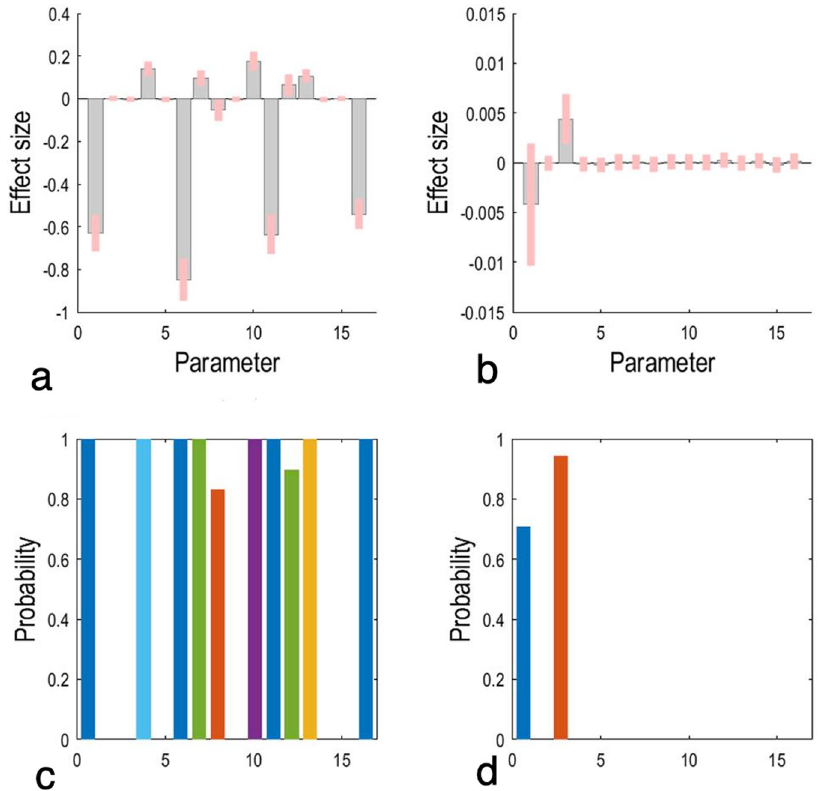
Fig. 3 Correlation results between effective connections and IAT scores through parametric empirical Bayesian framework. a shows each parameter ’ s effect size after Bayesian model averaging for the mean of all subjects, and c shows the corresponding posterior probabilities. b shows the effect size of correlations between each parameter and IAT scores and d shows the corresponding posterior probabilities. Here the threshold of the posterior probability is set to 0.9, so the current results indicate that a positive correlation between connection strength and IAT is observed in effective connection from the MFG to left putamen (i.e., parameter 3 in b , d ). IGD: 174 subjects; RGU: 244 subjects. Note: parameter 1: self-connection from left MFG to left MFG; parameter 2: effective connection from left MFG to left NAcc; parameter 3: effective connection from left MFG to left putamen; parameter 4: effective connection from left MFG to right MFG; parameter 5: effective connection from left NAcc to left MFG; parameter 6: self-connection from left NAcc to left NAcc; parameter 7: effective connection from left NAcc to left putamen; parameter 8: effective connection from left NAcc to right MFG; parameter 9: effective connection from left putamen to left MFG; parameter 10: effective connection from left putamen to left NAcc; parameter 11: self-connection from left putamen to left putamen; parameter 12: effective connection from left putamen to right MFG; parameter 13: effective connection from right MFG to left MFG; parameter 14: effective connection from right MFG to left NAcc; parameter 15: effective connection from right MFG to left putamen; parameter 16: self-connection from right MFG to right MFG; IGD: 22 subjects; RGU: 18